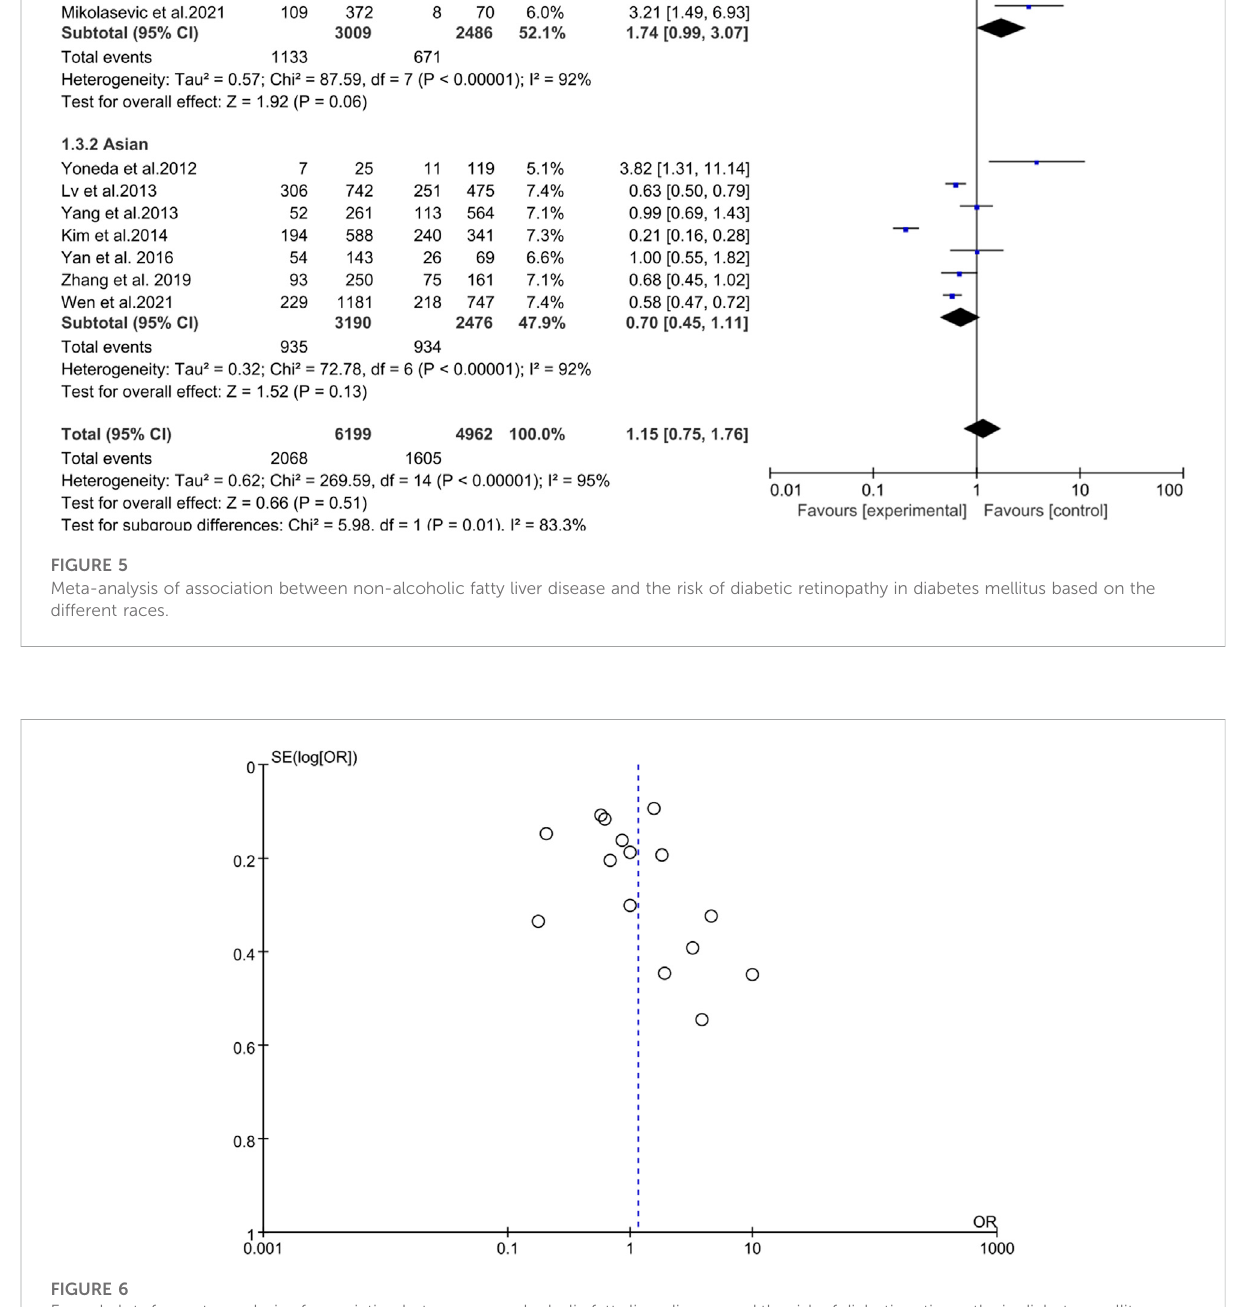
Frontiers in Molecular